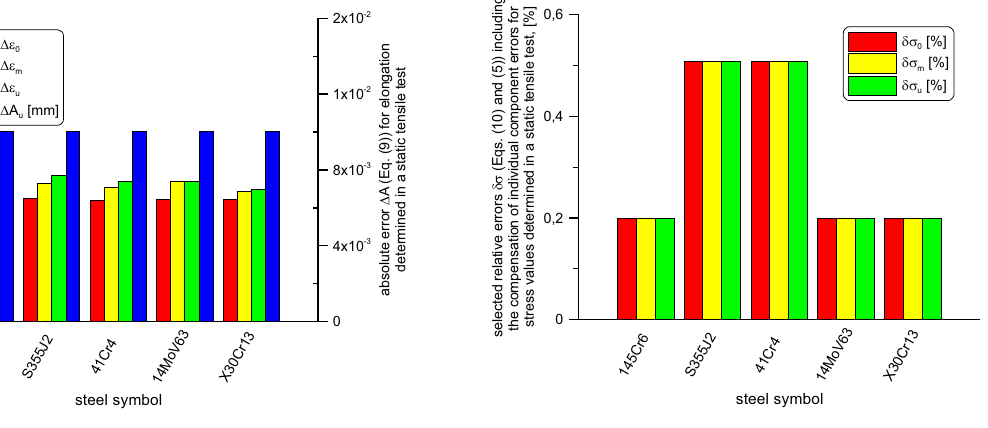
Figure 8: Comparison of the absolute errors Δ ε and Δ A for selected strain and elongation values determined in the static tensile test using equation ( 9 ) .